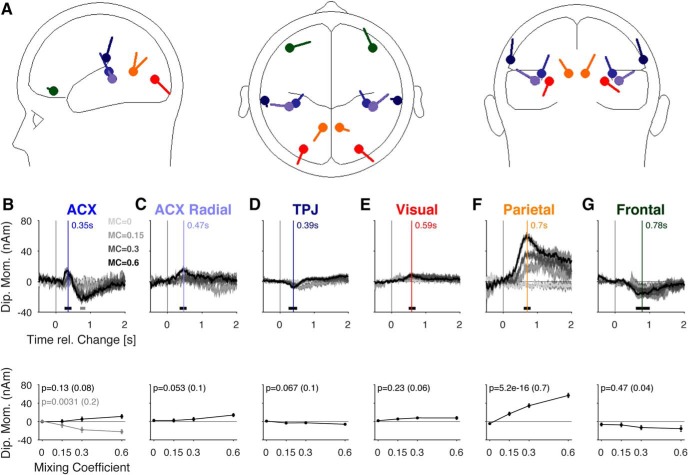
Contribution of the different sources to the change related response. A, The scalp potential was well approximated [residual variance (0–2000 ms) = 0.64%] by a mixture of six sources in each hemisphere, activating at different times after the change. The sources are located in the auditory cortex (blue, light blue, B, C), the temporo-parietal junction (dark blue, D), the visual cortex (red, E; provided for completeness), the medial-parietal cortex (orange, F), and finally the frontal cortex (green, G). All sources were estimated as bilateral pairs; however, potentials in B–G show averages across pairs. B, The first source activation was located close to the auditory cortex (blue in a A). It exhibited a significant dependence on change size only around 750 ms (bottom, gray, analysis window: 700–850 ms), while the P2-like potential (peak: 350 ms, vertical blue line, correspondingly in the following panels) was borderline insignificant (bottom, black, window: 250–450 ms). C, As before, we estimate a radial component of the AEP, which exhibited a borderline significant dependence on mixing coefficient (bottom, window: 350–550 ms). D, The activation of the temporo-parietal junction was very small and did not contribute significantly (window: 250–500 ms). E, The contribution from the visual source was nonsignificant (window: 500–700 ms). F, The activation in the parietal cortex exhibited a clear and significant dependence on the mixing coefficient. While the onset time remained similar across change sizes, the peak time was slightly delayed for lower change sizes, similar to potentials the scalp level (window: 600–800 ms). G, A further pair of sources was localized in the frontal cortex, which, however, did not show a significant dependence in their size on change size (window: 600–1000 ms). Error hulls and bars indicate ±1 SEM over n = 17 subjects, and only 3-s change time is shown. Effect size is given in parentheses after the p value.